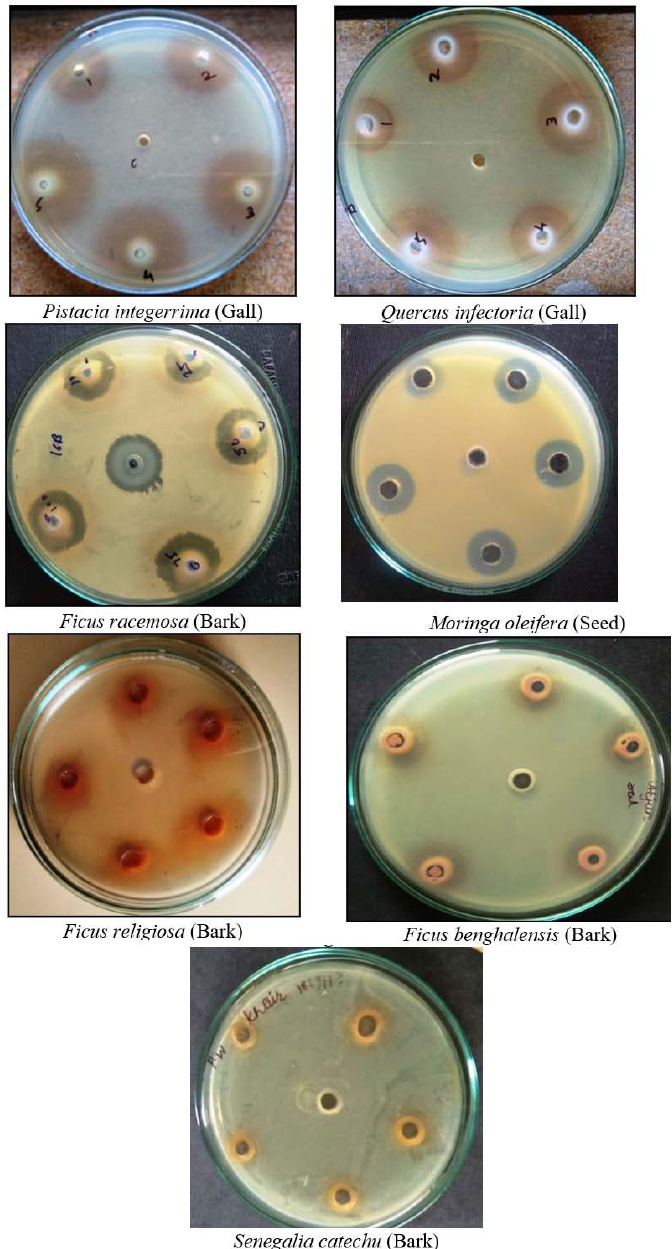
Fig. 1. Antimicrobial activity of various plant extracts using agar well diffusion